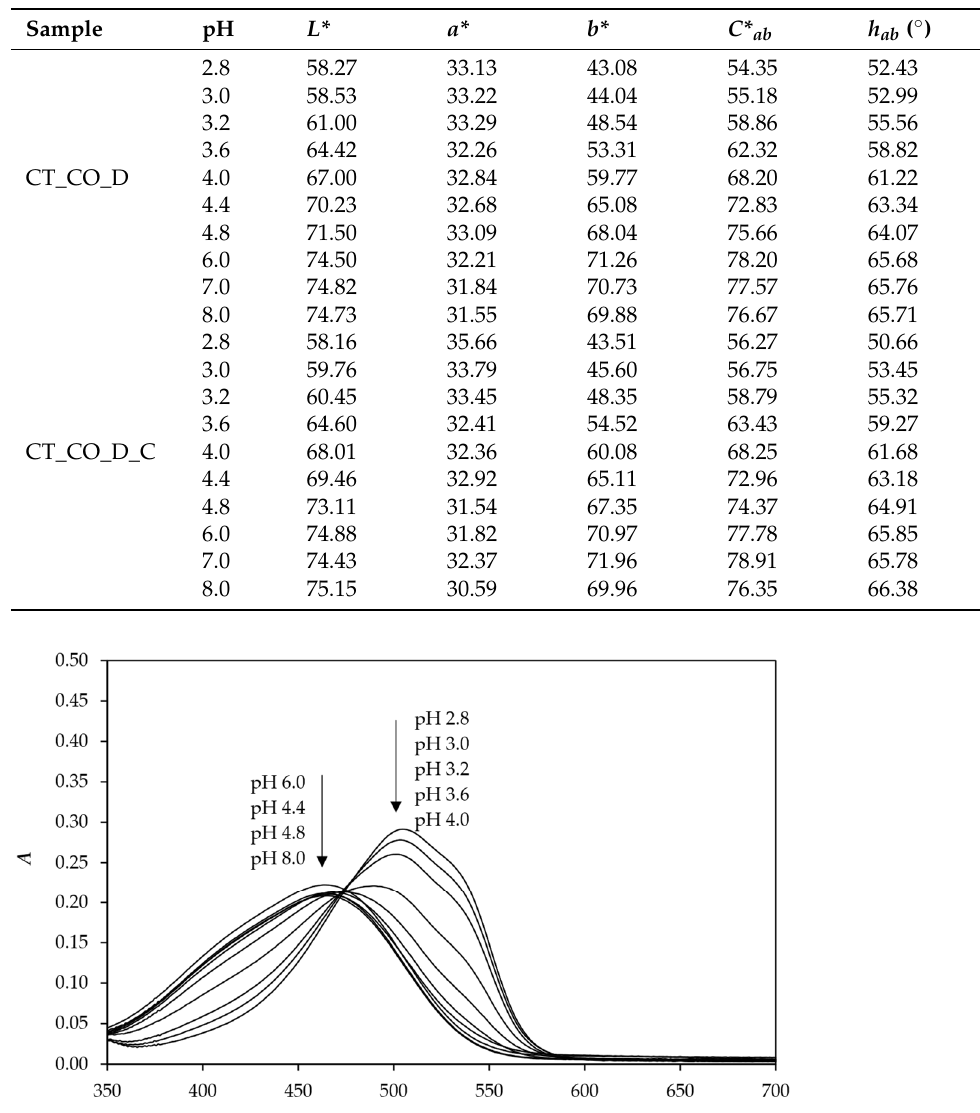
Table 4. Colour values CIELAB, chroma ( C* ab ) and hue angle ( h ab ) of samples CT_CO_D and CT- CO_D_C after immersion in buffer solutions of different pH values.